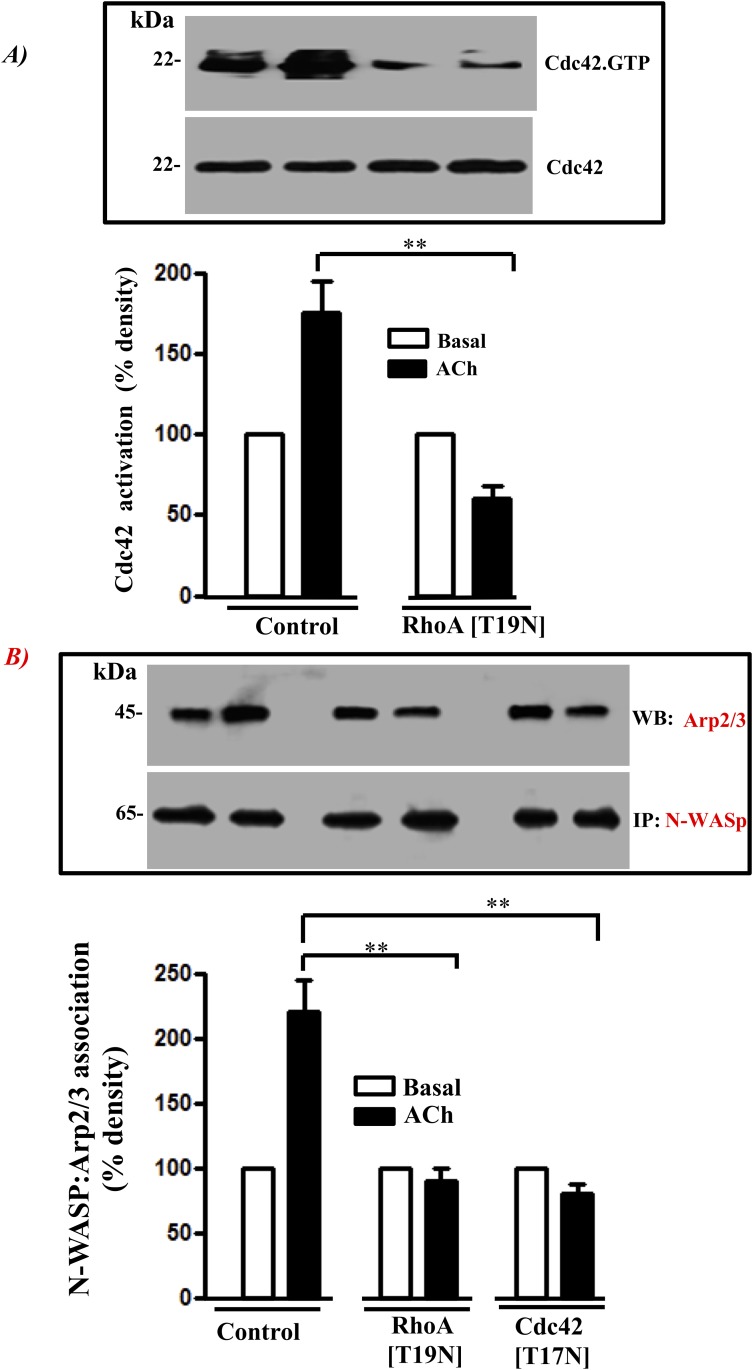
Activation of Cdc42 and N-WASP:Arp-2/3 complex association.A: Cultured smooth muscle cells expressing either control vector or RhoA dominant negative (RhoA [T19N]) were treated for 10 min with 1 μM ACh. Immunoprecipitates derived from 500 μg of protein using glutathione S-transferase-tagged p21-activated kinase (PAK) binding domain (PBD) beads were separated using SDS-PAGE and immunoblotted using Cdc42 antibody, and the results are expressed as densitometric values. Values are means ± SE for four experiments. B: Cultured smooth muscle cells expressing control vector or RhoA dominant negative (RhoA [T19N]) or Cdc42 dominant negative (Cdc42 [T17N]) were treated for 10 min with 1 μM ACh. Immunoprecipitates derived from 100 μg of protein using the N-WASP antibody were separated using SDS-PAGE and immunoblotted using Arp2/3 antibody. The results are expressed as densitometric values. Values are means ± SE of four experiments. **P<0.001.